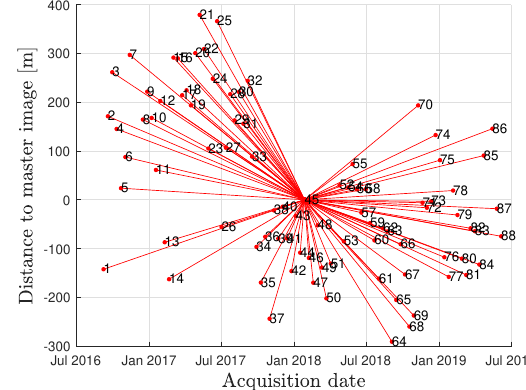
Figure 1. Temporal and spatial baselines for the N =88 SAR scenes.